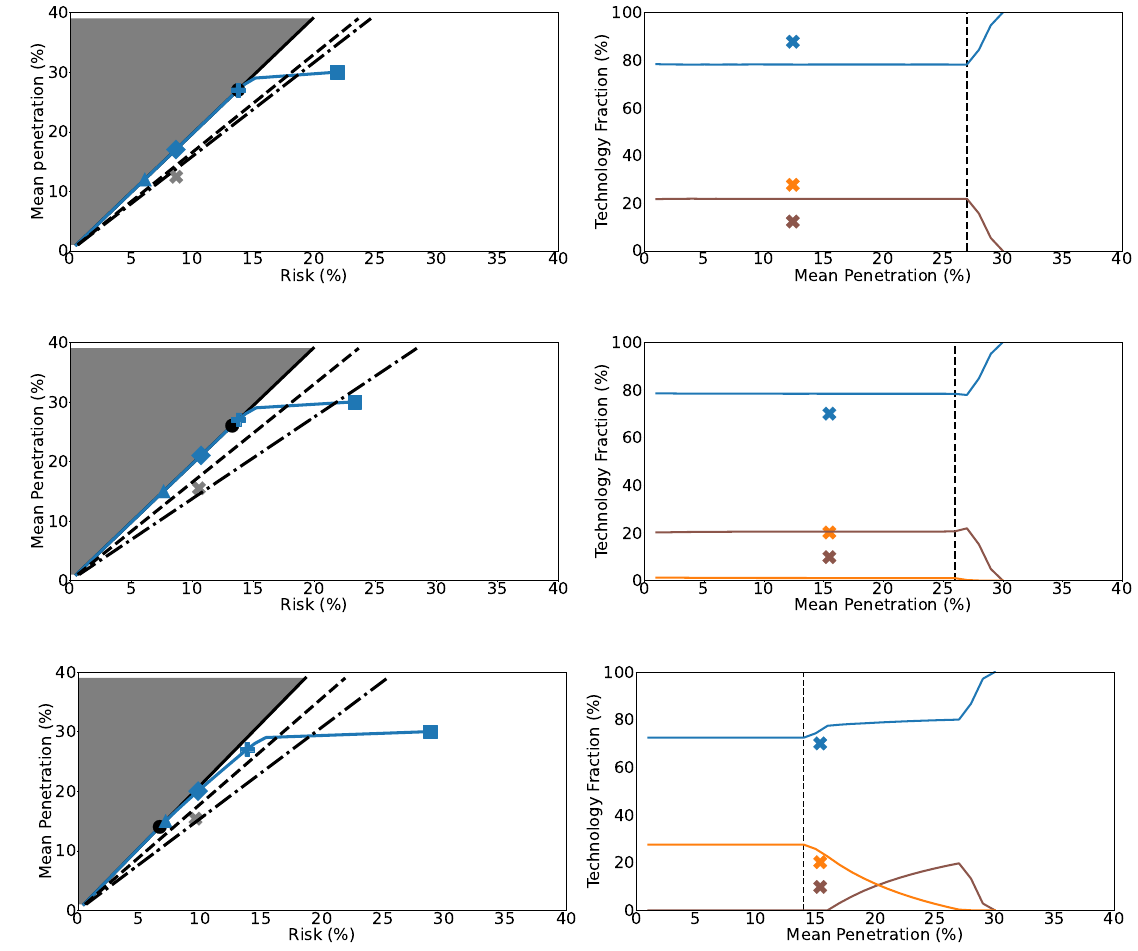
Figure 4. Left : approximations of the fronts with the risk, σ global/technology/base , in abscissa and the mean penetration (1), µ , in ordinate. Right : shares of wind (blue line), PV (brown line) and CSP (orange line) capacities versus the mean penetration for the global strategy with maximum-cost constraint. Top : PV-Wind. Middle : PV-Wind-CSP-SM1. Bottom :